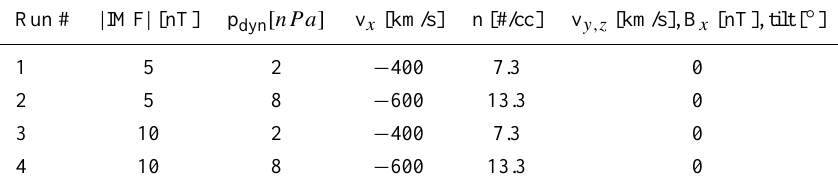
Table 1. Parameters for synthetic runs.